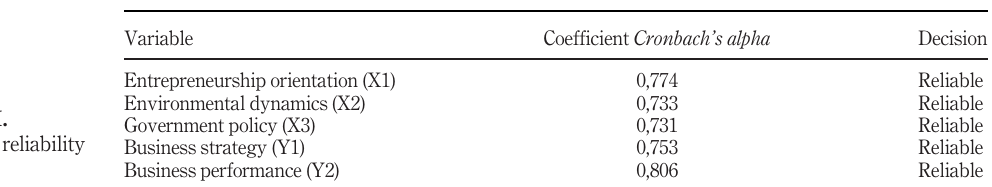
Table II. Variable reliability